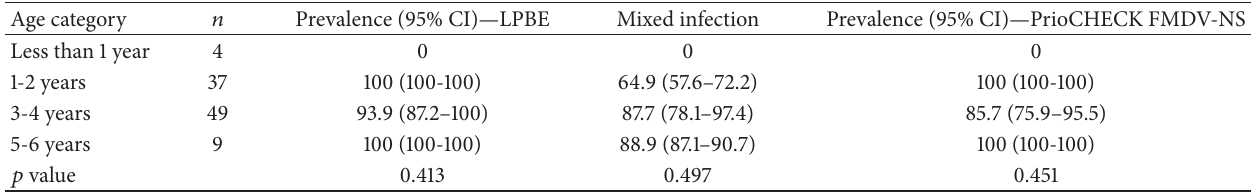
Table 2: Prevalence of LPBE results, mixed infection, and PrioCHECK FMDV-NS test results in relation to age.